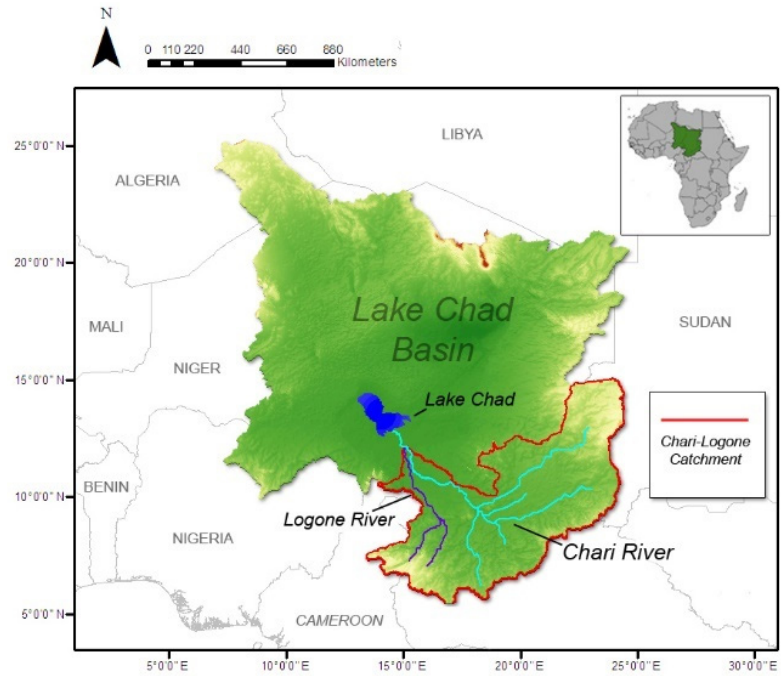
Figure 1. Map of the Lake Chad Basin located in Sahelian Africa. The catchment study region is outlined in red and located in the southeastern portion of the Basin.